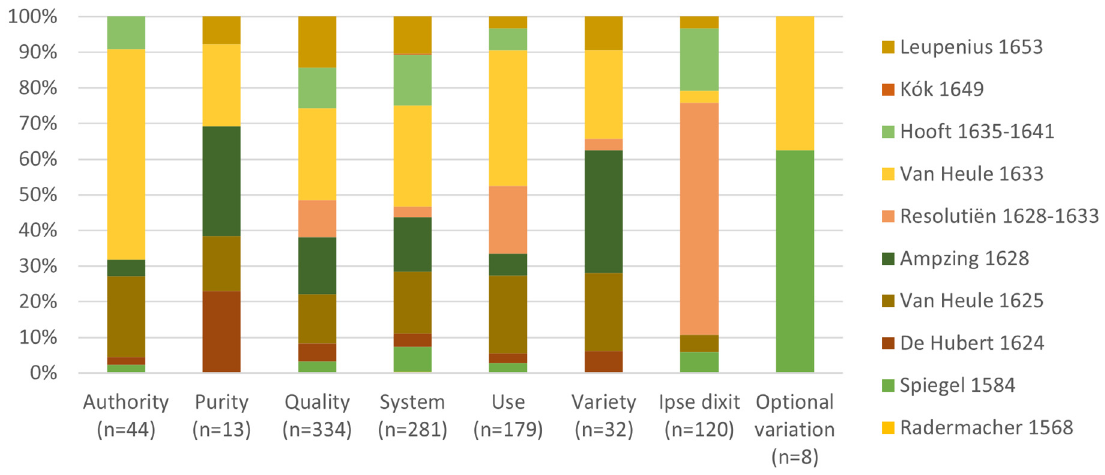
Figure 5. Relative distribution of normative works per top-level argument.